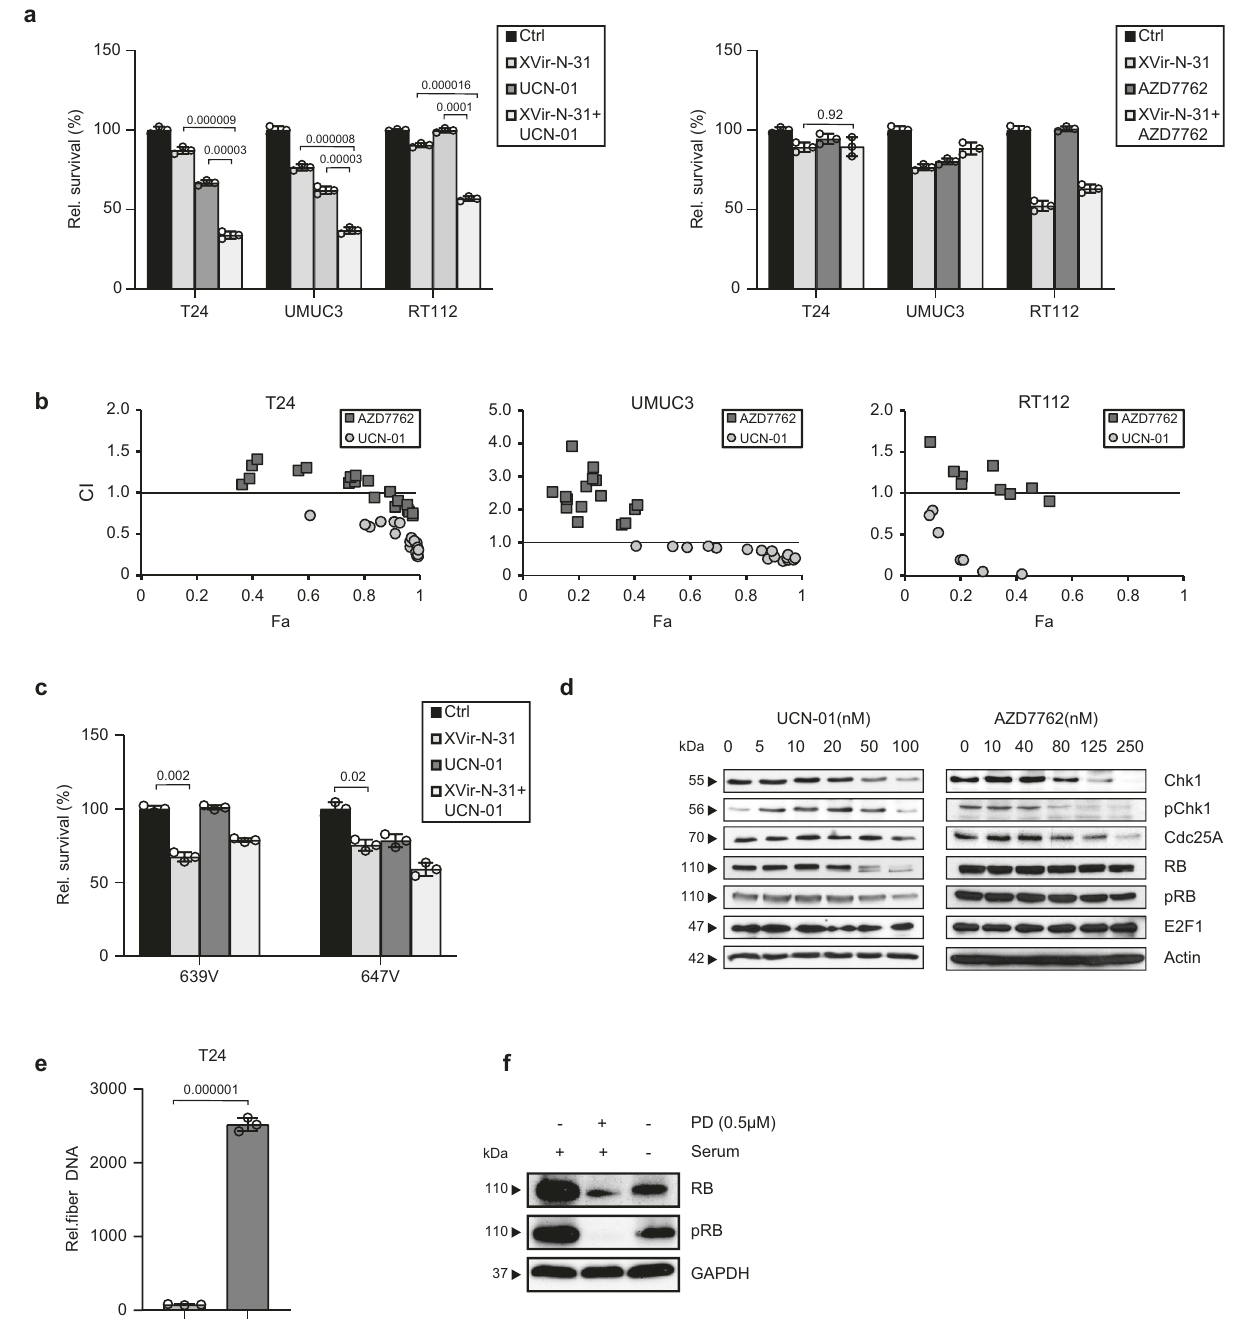
Fig. 1 | Combination therapies that downregulate RB expression enhance oncolytic virotherapy. a Cell proliferation analyses in bladder cancer cell lines. Bladder cancer cells were pre-treated with UCN-01 for 24h and infected with XVir- N-31(RT112(40nM,MOI400),T24(20nM,MOI40),andUMUC3(20nM,MOI20)). T24,UMUC3, and RT112 were pre-treated with AZD7762 (80nM)and infectedwith MOI40,MOI20,andMOI400ofXVir-N-31,respectively.Cellviabilitywasassessed at 4dpi. Data are shown as the percentage of surviving cells ( n =3, mean±SE relative to non-infected, untreated control. b Combination index (CI) plots show synergisticeffectsoncellviabilityincombinationwithUCN-01(circles)butnotwith AZD7762 (squares). CI values were calculated using the Chou – Talalay theorem. CI<1 synergism; CI=1 additivity; CI>1 antagonism; Fa: fraction affected. c RB- negative 647V and 639V cells were pre-treated with UCN-01 (20nM) for 24h and infected with MOI 2 and MOI 200 of XVir-N-31 respectively. Cell viability was